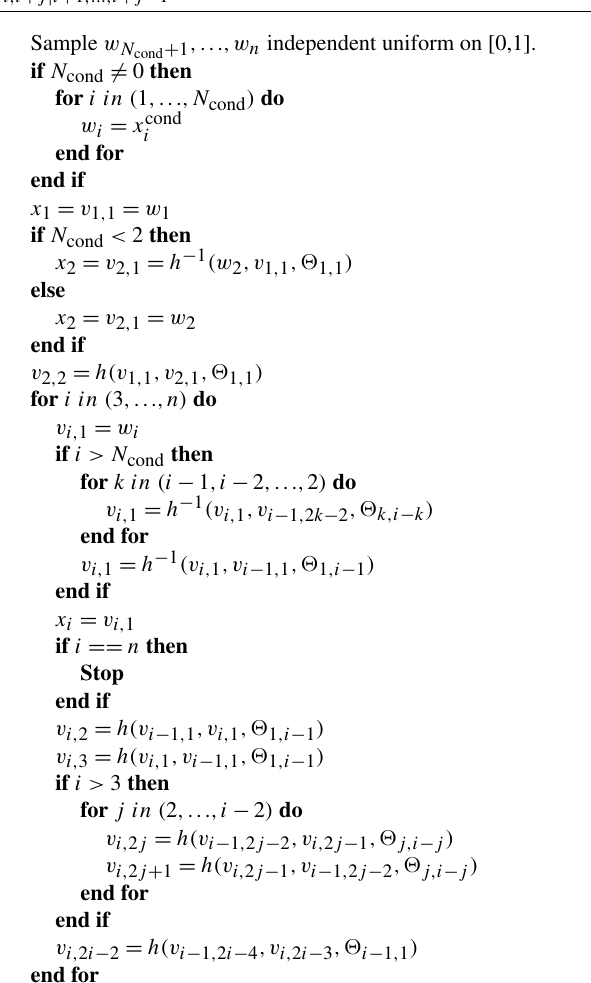
Algorithm 2 Algorithm to simulate uniform variables X